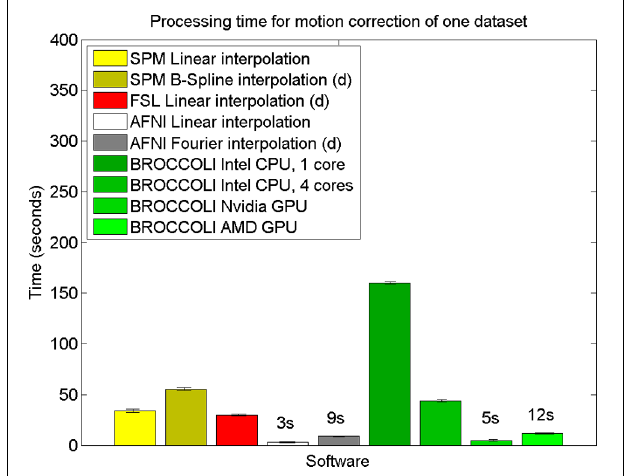
FIGURE 8 | Processing times for motion correction of one fMRI dataset of size 72 × 72 × 47 × 119 for the different software packages, averaged over 198 datasets. The error bars represent the standard deviation. All algorithms registered all volumes to the first one. The processing times for AFNI and AFNI OpenMP are the same, as the AFNI software does not have any OpenMP support for motion correction. Different interpolation modes were tested, as the software packages have different default settings for interpolation (d denotes the default interpolation).